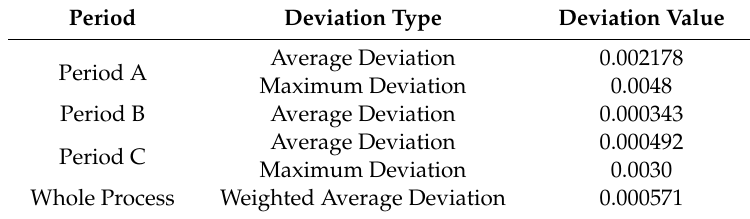
Table 2. Model evaluation of active current under small disturbance of grid voltage.